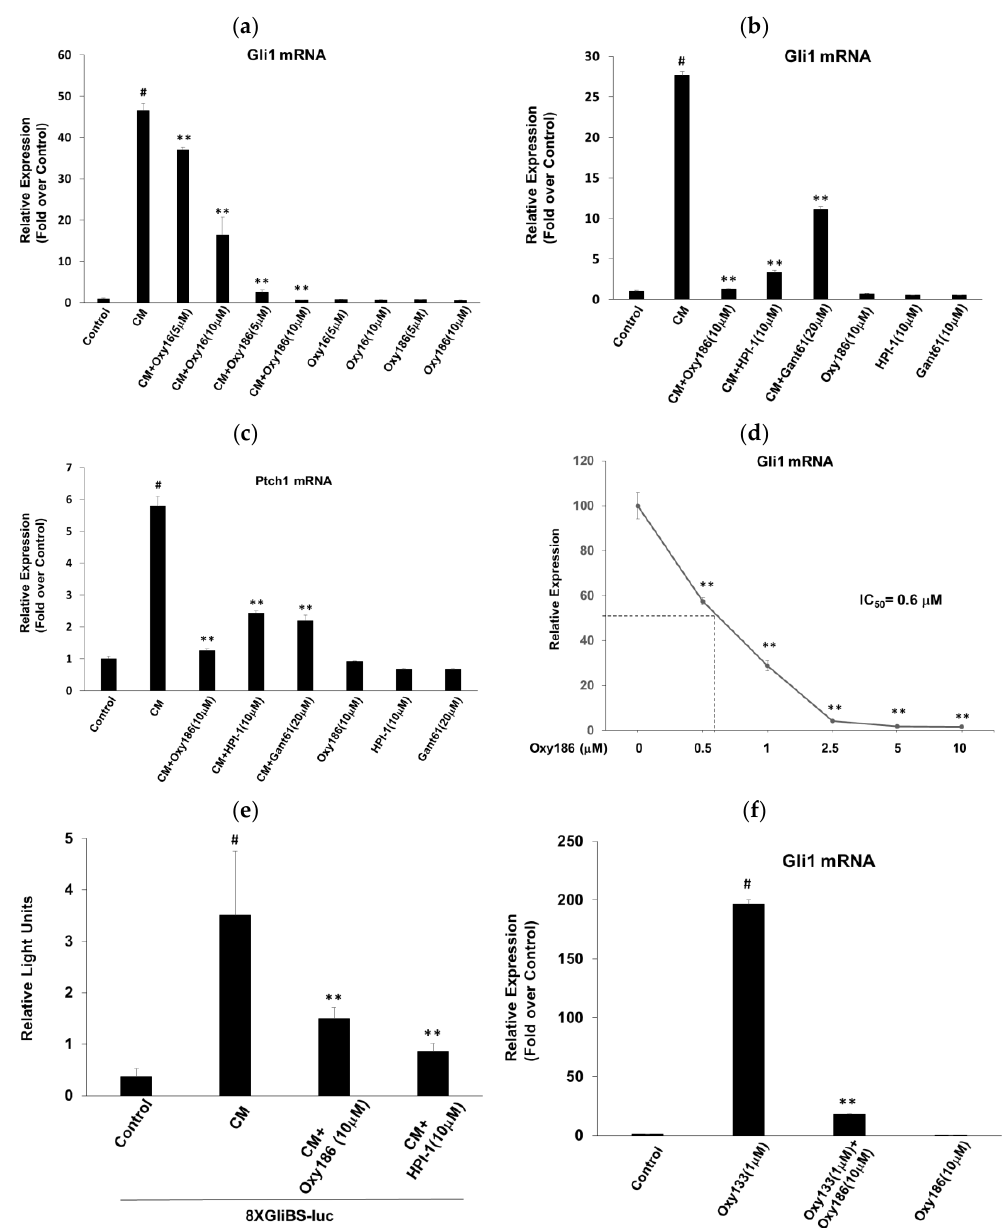
Figure 3. Inhibition of ligand-induced Hedgehog signaling. NIH3T3 cells were pretreated for 2 h with the oxysterols or various inhibitors, as indicated, in DMEM containing 5% FBS. Next, cells were treated with CAPAN-1 conditioned medium (CM) in the absence or presence of oxysterols or inhibitors. After 72 h, RNA was extracted and analyzed by Q-RT-PCR for the expression of Hh target genes Gli1 ( a , b , d ) and Ptch1 ( c ), and normalized to Oaz1 expression. ( e ) NIH3T3 cells cultured in 24-well plates were transfected with a Gli response-element reporter (pGL3b-8xGliBS-Luciferase) plasmid and a pTK-Renilla-Luciferase plasmid. 24 h after transfection, cells were treated with the test agents, as indicated for 72 h. Luciferase activity was measured and normalized to the Renilla luciferase activity. ( f ) NIH3T3 cells were treated with the oxysterols, as indicated, in DMEM containing 5% FBS for 72 h. Q-RT-PCR was performed as described in ( a ). Data from a representative experiment are reported as the mean of triplicate determinations ± SD (** p < 0.01 vs. CM-treated cells ( a – e ) or Oxy133 ( f ); # p < 0.01 vs . control).